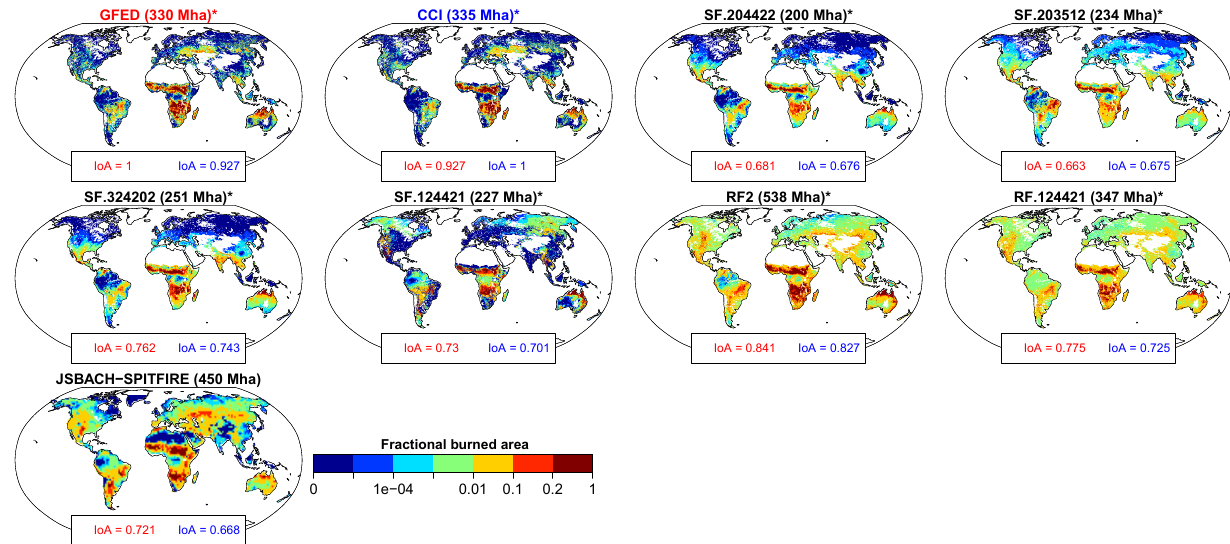
Figure 4. Mean annual fractional burned area in 2005–2011 from observational datasets and global fire models. Numbers in brackets are the global mean annual burned area. In the case of the ∗ symbol, the computation of global total annual burned area considered the com- mon spatial–temporal occurrence of missing values in all SOFIA and random forest models in the 0.25 ◦ grid cells. IoA is shown with respect to GFED (red) and CCI (blue), respectively. All maps were aggregated to the coarsest common spatial resolution (i.e. JSBACH, ∼ 1.875 × 1.875 ◦ ) for the computation of IoA and total burned